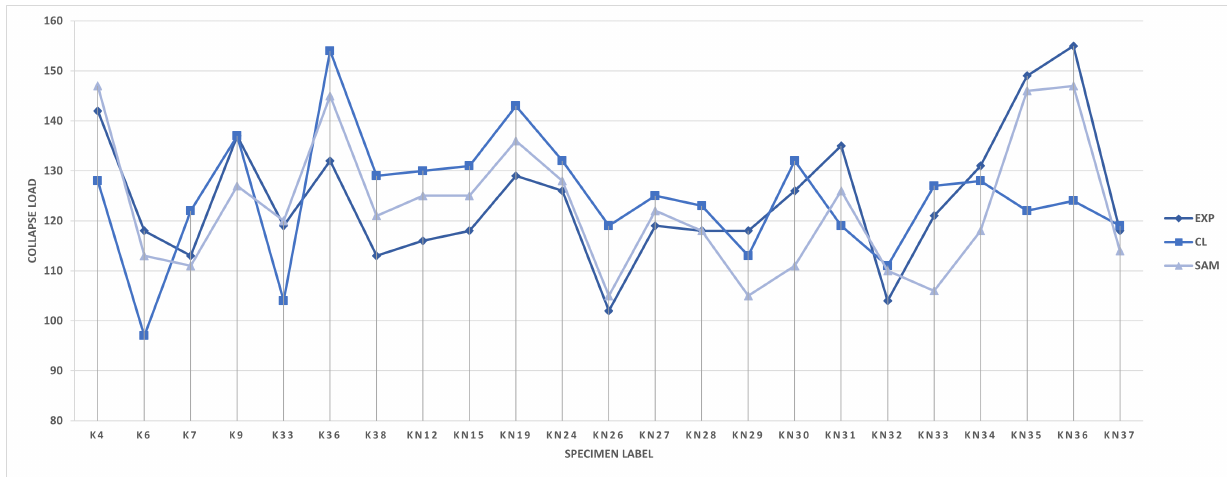
Figure 10. Collapse load from EXP, CL, and present SAM